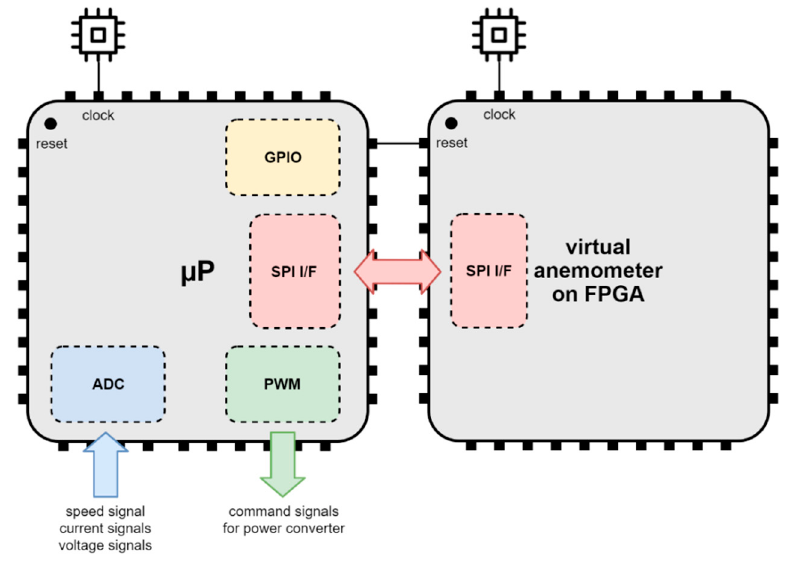
Figure 2. Synopsis of the interaction between the main microprocessor and the coprocessor.